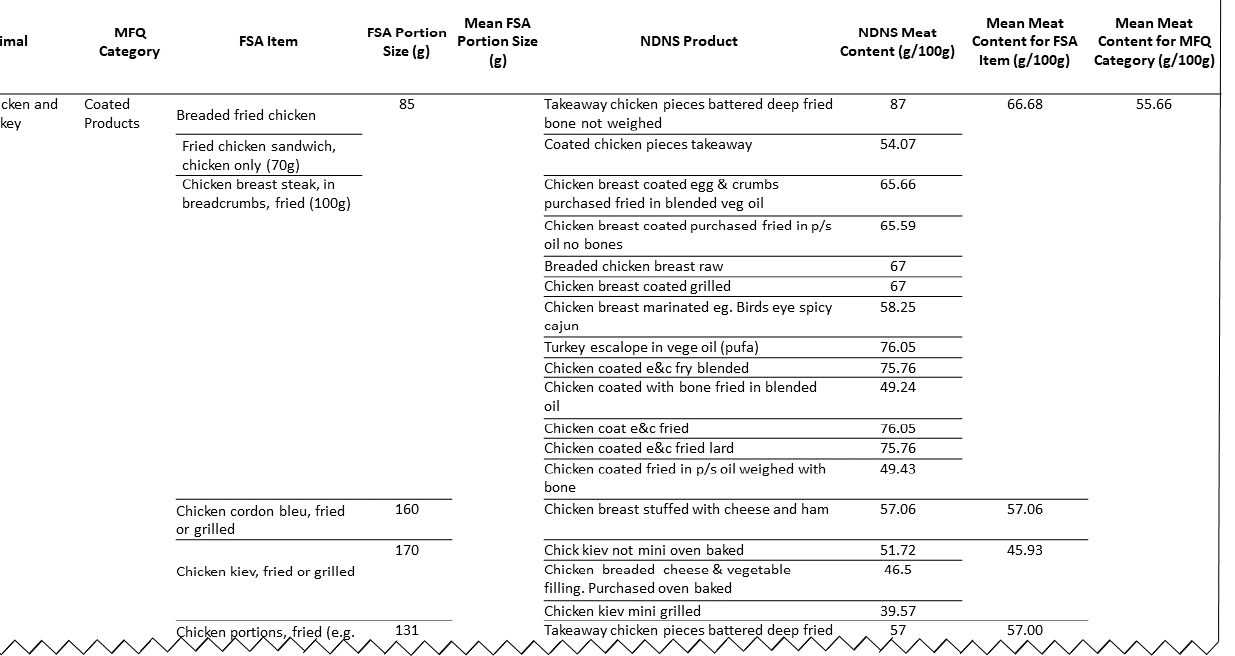
Figure 1. Extract of the underlying data for the chicken and turkey category of the Oxford Meat Frequency Questionnaire (MFQ). Extract depicts the underlying portion size information from the Food Standards Agency (FSA) food portion sizes book and the underlying meat content information (g/100 g serving) from the National Diet and Nutrition Survey (NDNS) Year 10 food composition database.